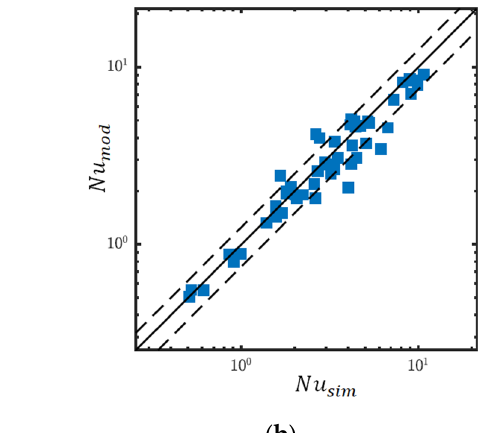
Figure 10. Comparison between results for Euler number (cid:1831)(cid:1873) (cid:3034) ( a ) and Nusselt number (cid:1840)(cid:1873) (cid:3034) ( b ) obtained from CFD simulations ( x -axis) and fitted models ( y -axis). Legend: analysis point of parametric study, — parity, - - - - ±25% deviation.